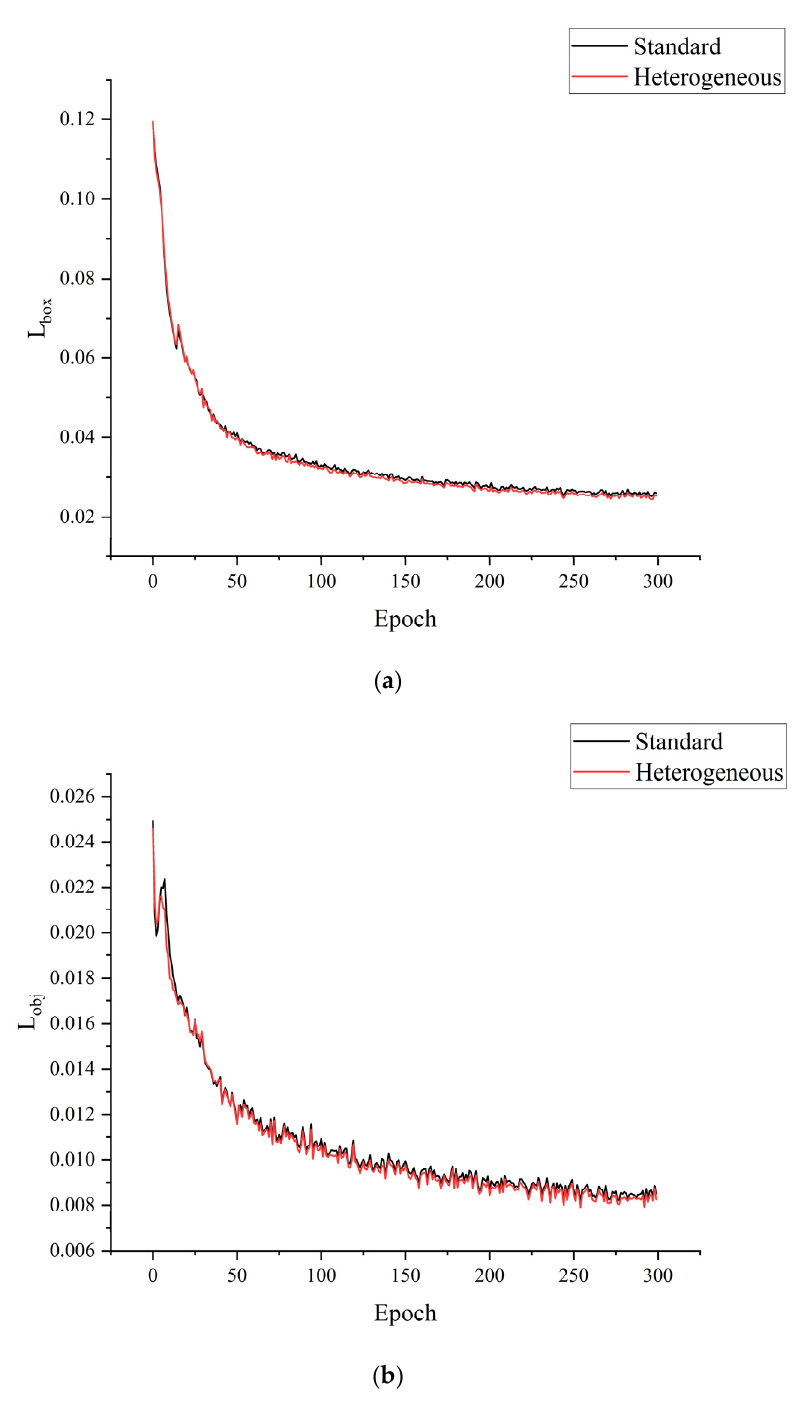
Figure 8. Comparison of the Standard Convolution and Heterogeneous Convolution for ( a ) box loss; ( b ) object loss.